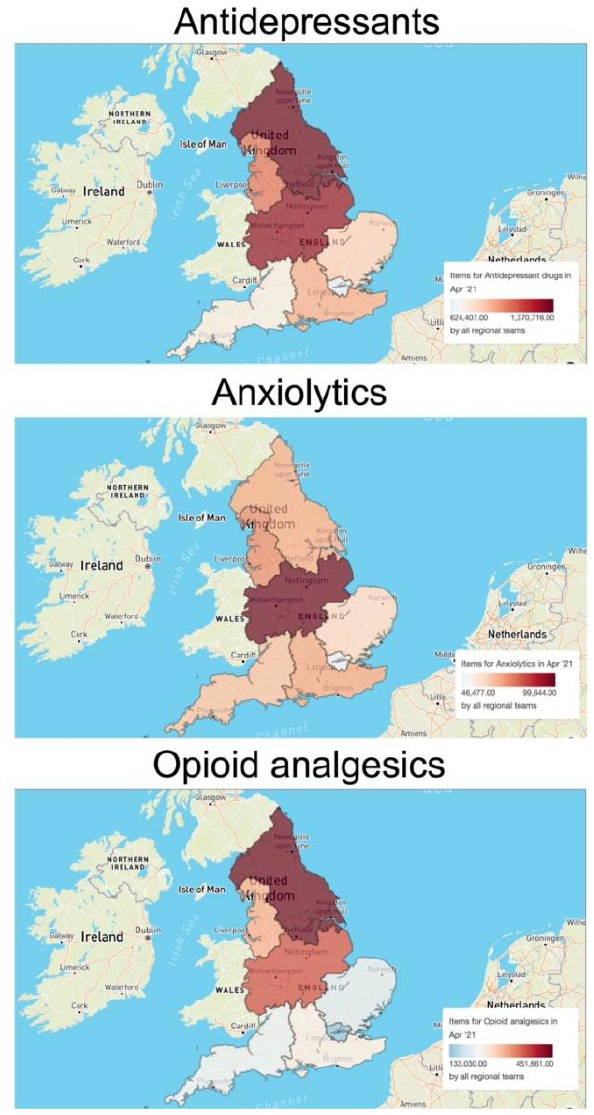
Figure 2. Regional differences in the prescription volumes of three selected classes of neuroactive pharmaceuticals (antidepressants, anxiolytics, opioid analgesics) in England in April 2021. The maps and related data were generated using the OpenPrescribing database (https://openprescribing. net/, accessed on 1 February 2022). The volume of each class of pharmaceuticals is expressed as number of items dispensed in April